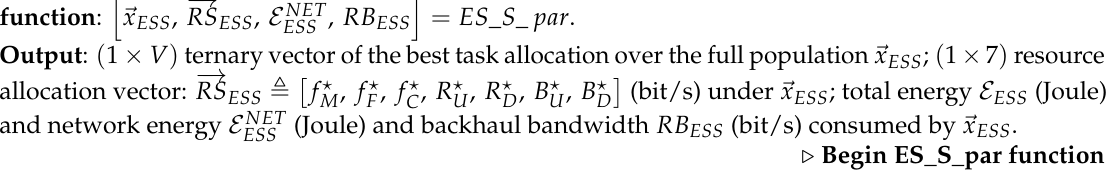
Algorithm 2 ES_S_par